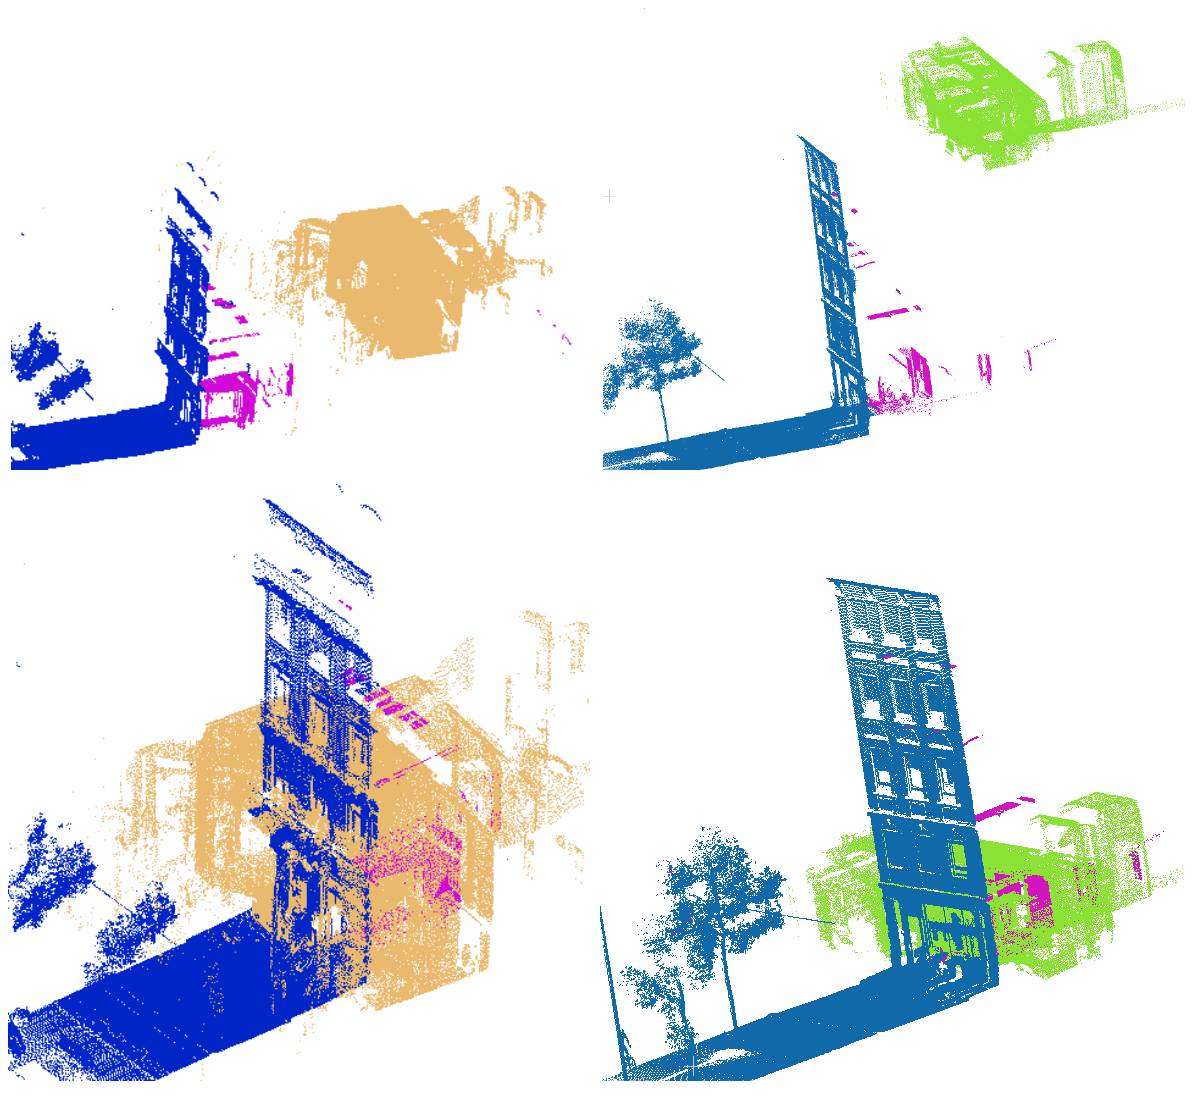
Figure 12. Result of the test of our algorithm on two pairs of indoor/outdoor scans, Top: the initial position of each pair, Bottom: The position of each pair after registration,pink points represent the indoor points detected from the outdoor